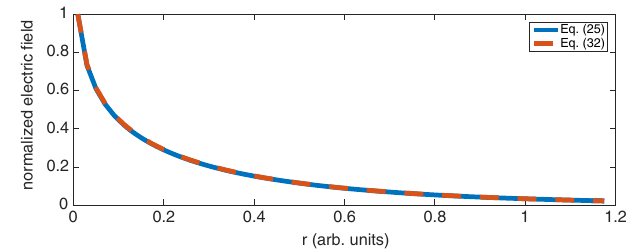
FIG. 3. Comparison between the Green ’ s function in free space computed with Eq. (25) (blue line) and Eq. (32) (red dashed line) with 120 summation terms, as a function of the radial coordinate and φ ¼ π = 2 , for a focal distance F ¼ 1